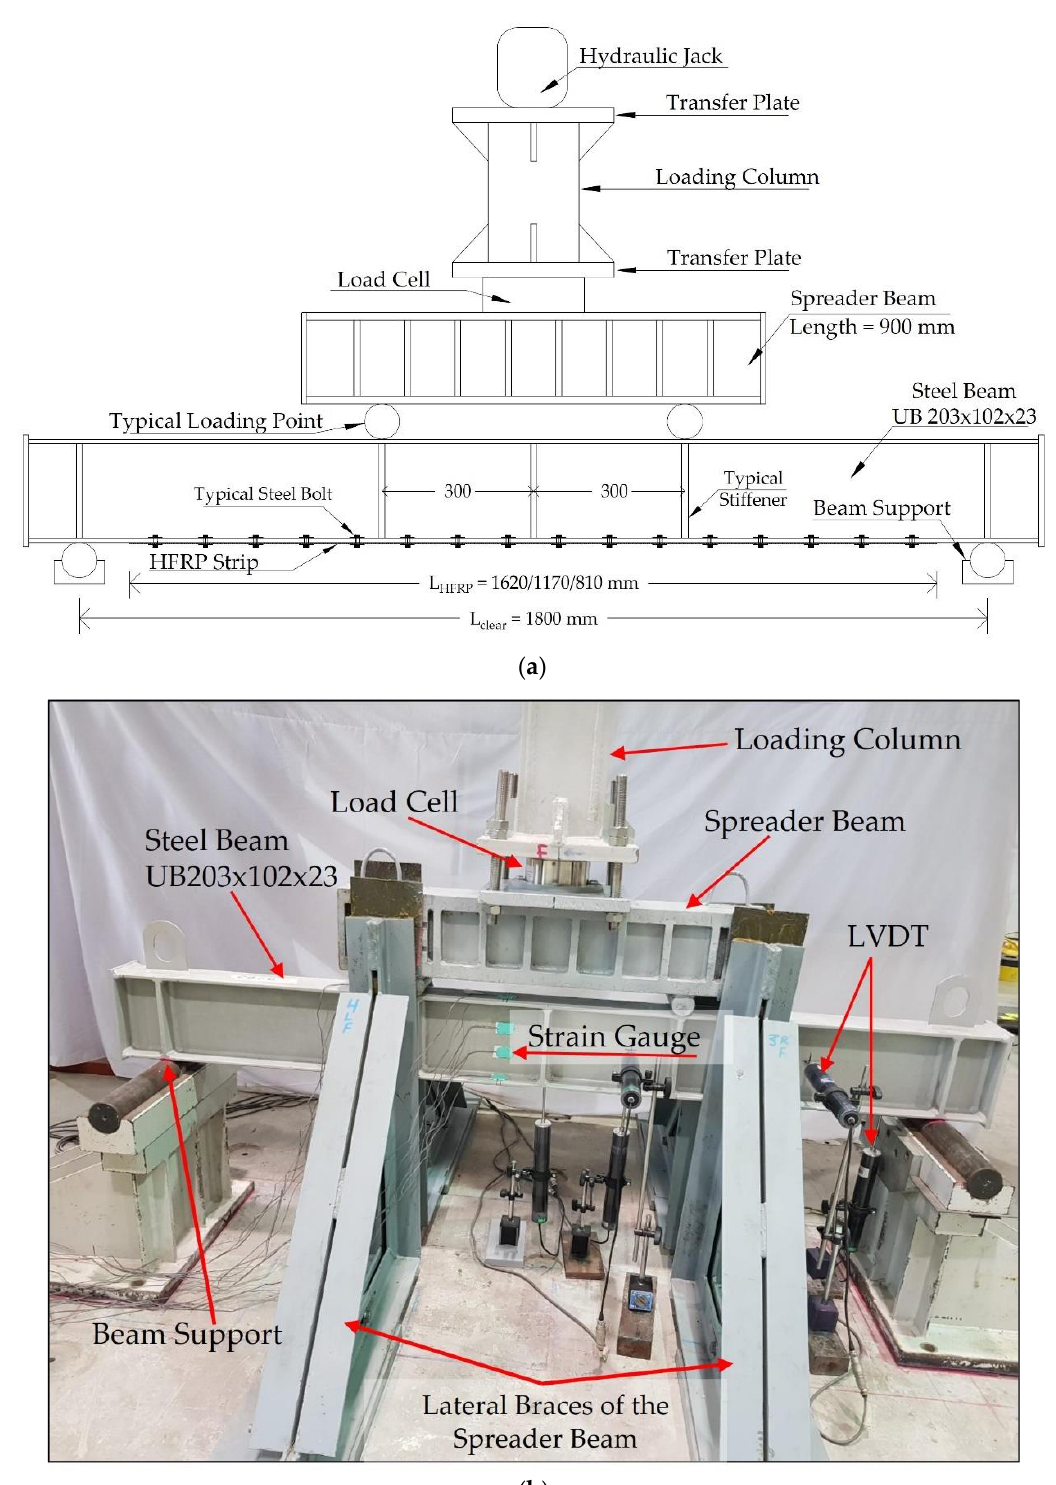
Figure 7. ( a ) Schematic of the test setup (dimensions in mm); ( b ) photo of the test setup. Electrical resistance strain gauges were mounted at various locations on the strength- ened beams to enable capturing the strain distribution along the HFRP strips and across the beams’ cross -sections. All beams were instrumented with strain gauges at two sections (mid-segment and edge-segment) to monitor the generated strains under pure flexure and the combined shear – flexural effect. The HFRP strips were instrumented by electrical strain gauges along half the length of the strip. The number and locations of the mounted gauges varied according to the length of the HFRP strip and the spacing between bolts. The locations of the strain gauges on the tested beams are displayed in Figure 8. In order to obtain the experimental load – deflection curves and deflection profiles, all beams were instrumented with six linear variable displacement transducers (LVDTs) with a range of ±100 mm. Four LVDTs were placed along half the span of the beam (see Figure 8) to meas- ure the vertical displacements and acquire the specimens’ deflection profiles at different loads. In addition, two more horizontal LVDTs were mounted perpendicular to the beam’s web to measure any out -of-plane deflection in case of lateral torsional buckling. The exact locations of the LVDTs are displayed on CB in Figure 8. It is worth mentioning that LVDT-1 at the mid-span was used to generate the load – deflection curve of each beam. Tests were conducted in a displacement-controlled manner with a rate of 1.5 mm/min to capture the post-peak response of the specimens. The load was applied using a 500 kN MTS hydraulic actuator. The applied loads were recorded by a 500 kN load cell which was placed between the loading column and the spreader beam (see Figure 7). All meas- uring devices were connected to a digital data logger that recorded the respective meas- urement per second. The accuracy of the recorded displacements and loads was up to 0.01 mm and 0.0001 kN, respectively.